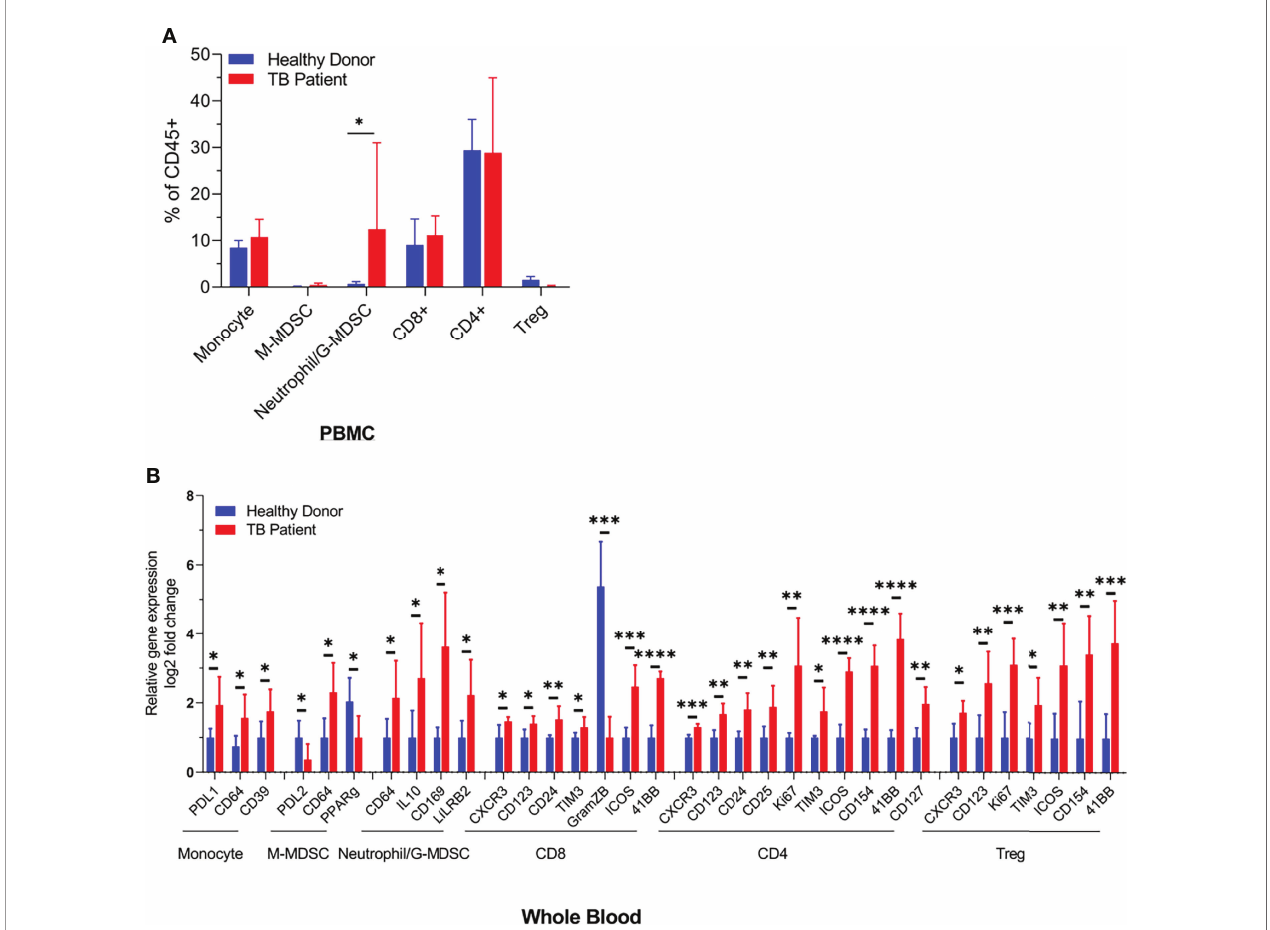
FIGURE 1 | Distribution of monocyte and neutrophil-derived myeloid-derived suppressor cells (MDSCs) in the blood of healthy donors and tuberculosis patients. Blood samples from either healthy donors ( n = 5) or TB patients ( n = 5) were analyzed using CyTOF (mass cytometry) for immune cell populations. N-MDSCs are increased in TB patients who also show a reduced activation of CD8 T cells (* p < 0.05, ** p < 0.005, *** p < 0.0005, **** p < 0.01, two-tailed t -test). Individual CyTOF pro fi les, biomarkers, and sample data are shown in Supplementary Table 1 and Supplementary Figure 3